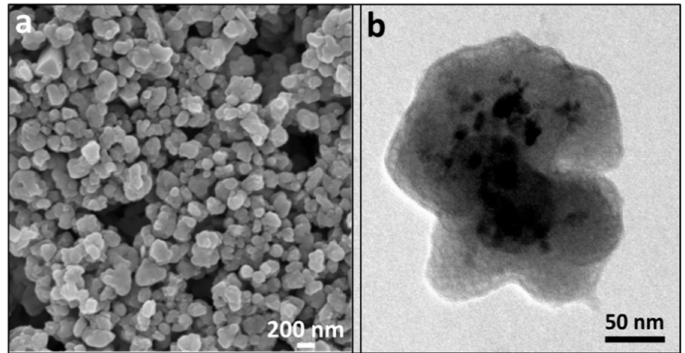
Figure 5. Scanning electron microscopy (SEM) ( a ) and TEM ( b ) micrographs of the Fe 3 O 4 @Al(OH) 3 NPs.